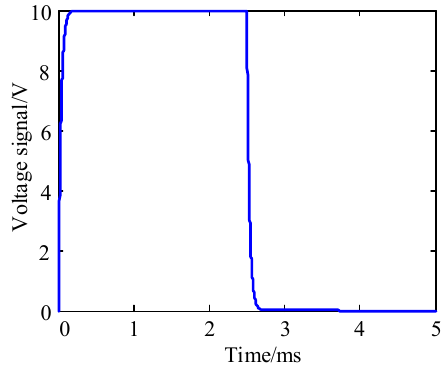
Figure 4. Pulse excitation voltage signal.